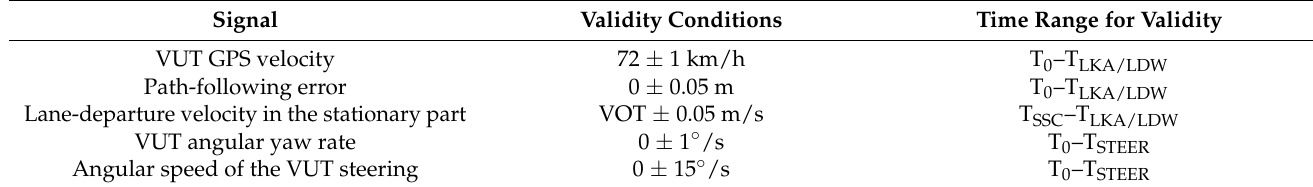
Table 1. Regulation limits for LSS testing according to NCAP regulation.